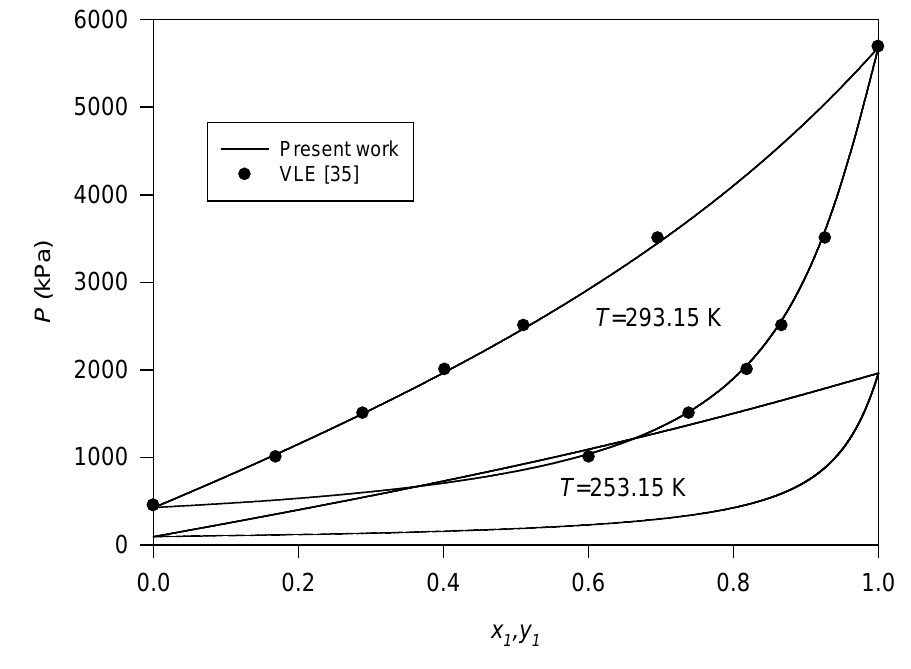
Figure 7. VLE for the R744 (1) + R1234ze(E) (2) binary pair.